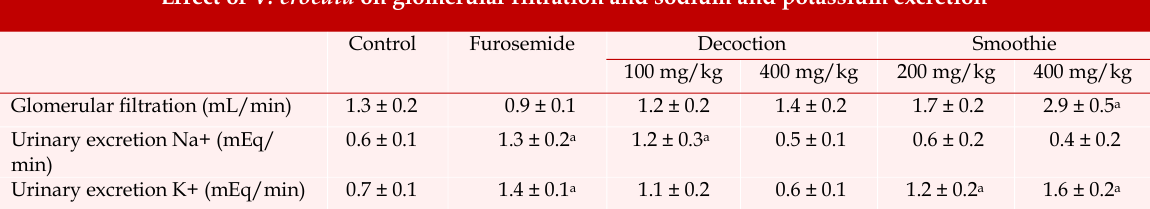
Effect of V. crocata on glomerular filtration and sodium and potassium excretion